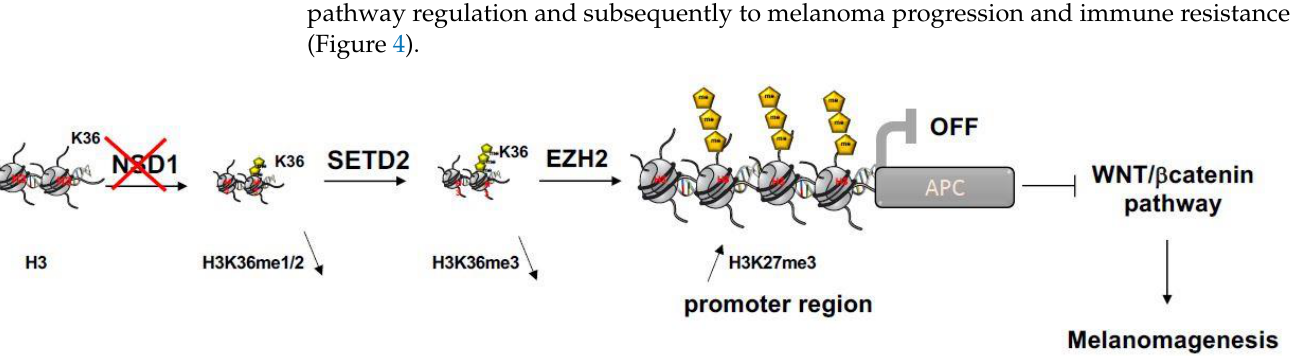
Figure 4. Epigenetic mechanisms driven by the histone lysine methyltransferases NSD1, SETD2 and EZH2 in cutaneous melanoma progression through WNT/bcatenin pathway regulation.